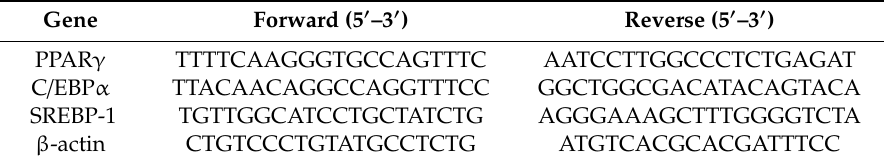
Table 1. Primer sets for real-time quantitative polymerase chain reaction. Gene Forward (5 (cid:48) –3 (cid:48)